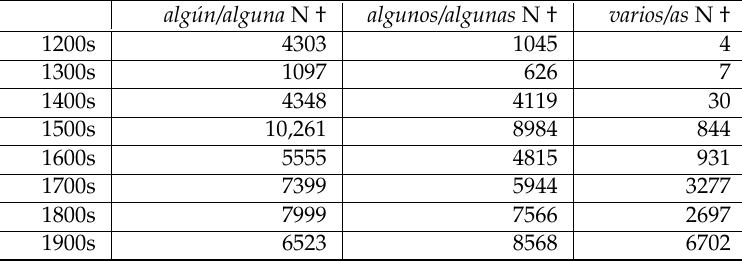
Table 7. Indefinite determiners in Castilian in CdE (raw figures).